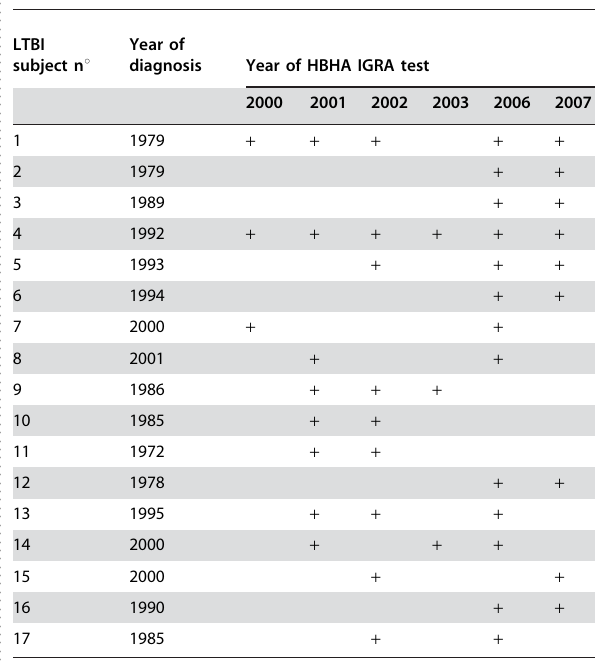
Table 1. Longitudinal follow-up of LTBI with the